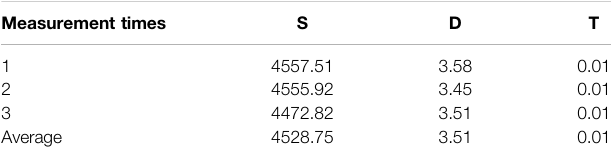
TABLE 3 | Background measurement.